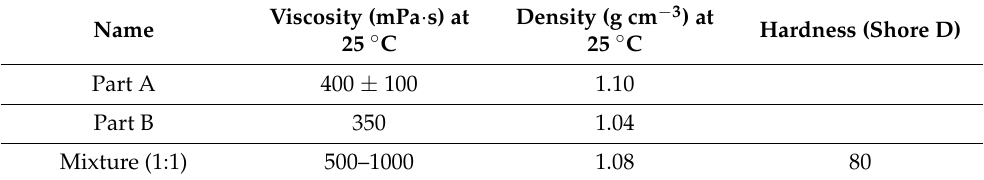
Table 2. Properties of epoxy resin.